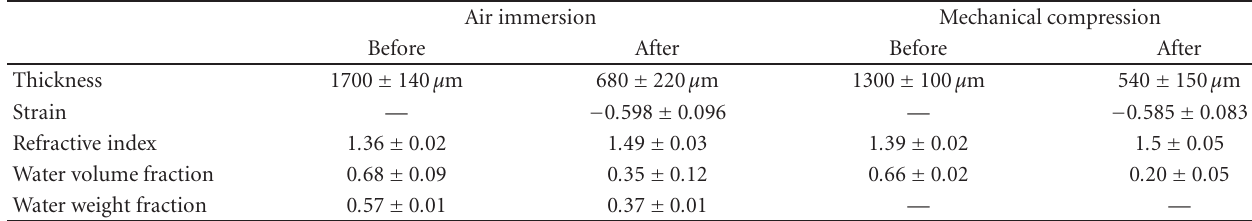
Table 1: Ex vivo porcine skin results for air immersion and mechanical compression. Errors are ± 1SD. Air immersion Mechanical